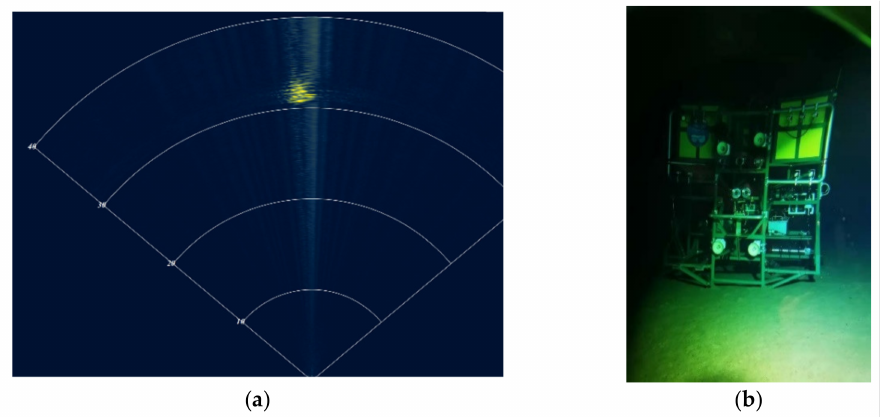
Figure 19. Imaging of the MB-FLS: ( a ) sonar image; ( b ) deep-sea video landers (target).